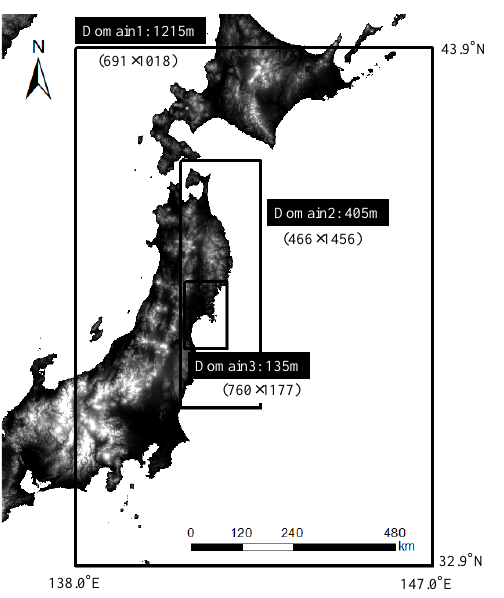
Figure 9. Five regions of terrain data used for the tsunami numerical run-up simulations in the Soma area (Domain 1, Domain 2, Domain 3, Domain 4 and Domain 5). The numbers in parentheses are the east-west and north-south mesh dimensions. Table 10. Calculation conditions for the nonlinear longwave equation used in the tsunami numerical simulations for Sendai and Kesennuma.